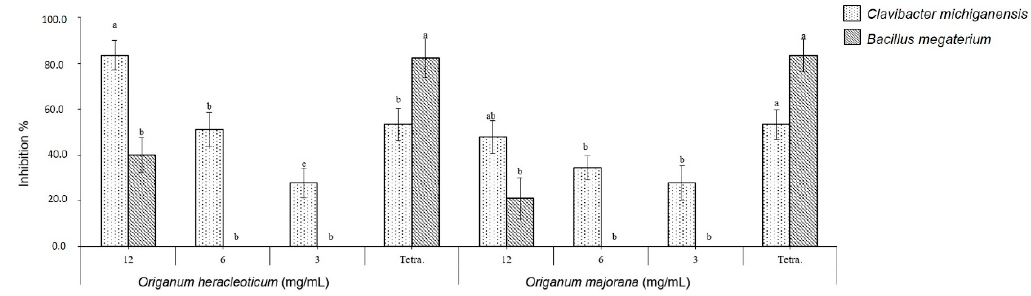
Bars with di ff erent letters for each tested bacteria indicate mean values significantly di ff erent at p < 0.05 Figure 4. Antibacterial activity of O. heracleoticum and O. majorana EOs against Gram-positive according to the Tukey B test between di ff erent tested concentrations. Data are expressed as mean ± bacteria. Bars with different letters for each tested bacteria indicate mean values significantly different at P < 0.05 according to the Tukey B test between different tested concentrations. Data are expressed as mean ± SDs.